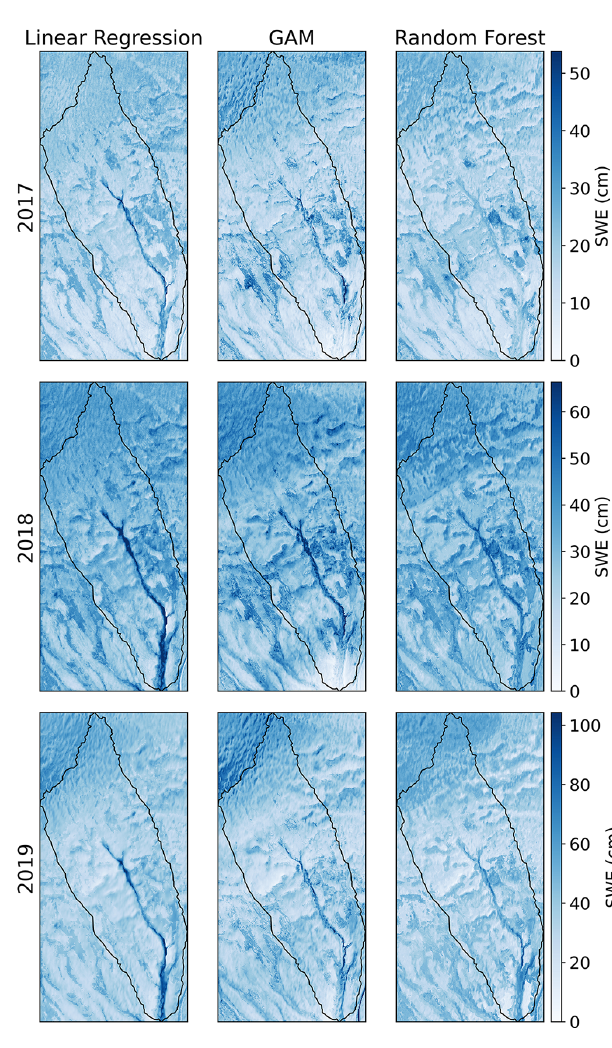
Figure A5. All three statistical models trained on individual years at Teller. The scale of the SWE changes from year to year, depending on the annual